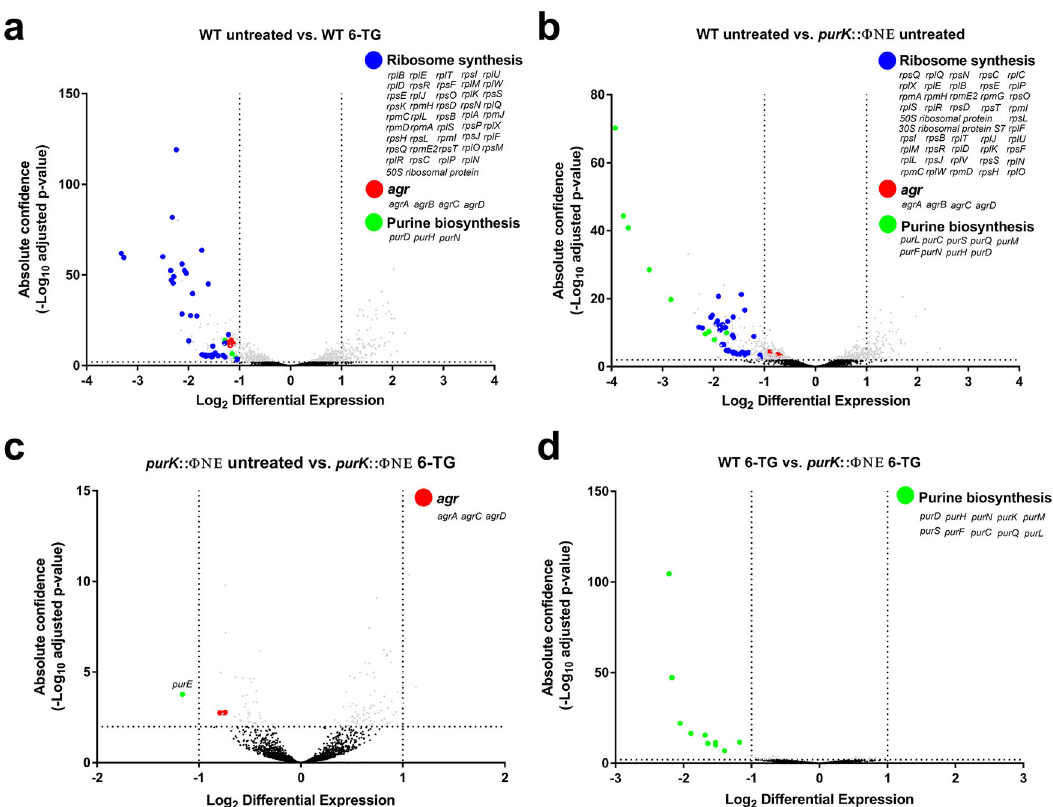
Fig. 7 6-TG abrogates toxin production by reducing transcription from the agr locus and from genes encoding for ribosomal proteins. a RNA-seq analysis of wild-type S. aureus cultures treated with a vehicle control or 6-TG (10 µ g/mL) in TSB. Data points above the dashed lines along the x -axis represent p ≤ 0.01. Data points outside of the dashed lines along the y -axis represent fold changes of ≥ 2.0. Results are from four independent experiments. b RNA-seq analysis of S. aureus purK :: ΦΝΣ cultures treated with a vehicle control compared to wild-type S. aureus cultures treated with a vehicle control in TSB. Results are from four independent experiments. c RNA-seq analysis of S. aureus purK :: ΦΝΣ cultures treated with a vehicle control or 6-TG (10 µ g/mL) in TSB. Results are from four independent experiments. d RNA-seq analysis of wild-type S. aureus cultures and S. aureus purK :: ΦΝΣ cultures treated with 6- TG (10 µ g/mL) in TSB. Results are from four independent experiments. Statistical signi fi cance was determined using a negative binomial distribution. Detailed RNA-seq data can be found in Supplementary Data